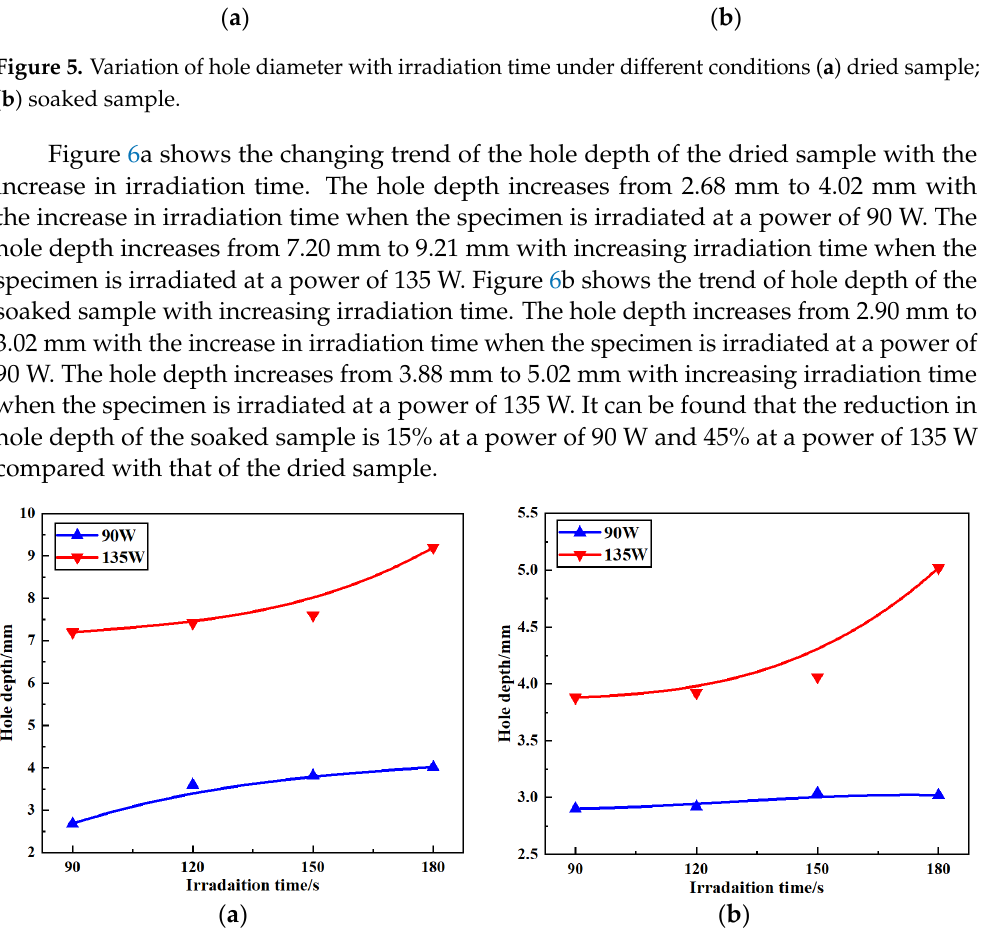
( b ) Figure 7. ( a ) Image of rock surface; ( b ) Magnified view of the small hole. 3.3. Efficiencies of Rock-Breaking under Laser Irradiation Modified specific energy ( MSE ) is defined as the amount of energy required per unit mass of rock sample and is used in this study as a criterion to measure the efficiency of rock destruction, which can be expressed as [10,13]: R P